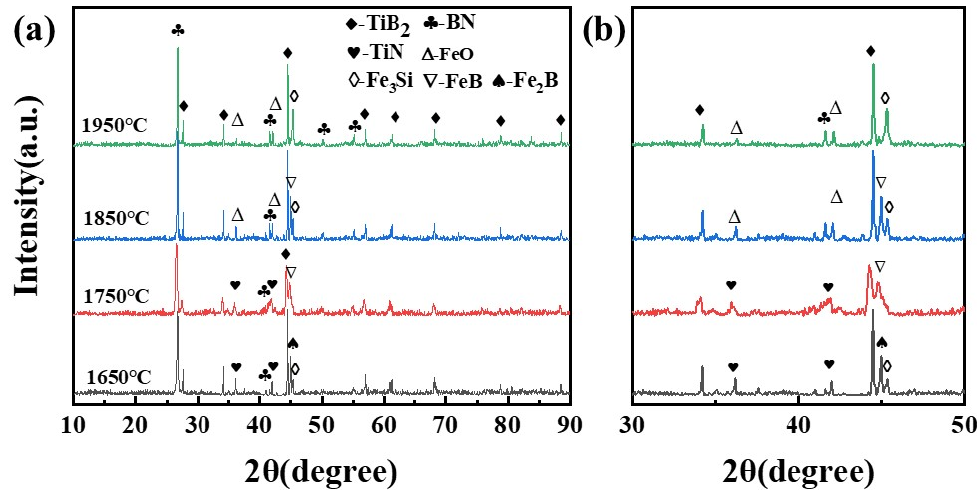
Figure 7. ( a ) XRD patterns of TiB 2 -BN-SiC composite ceramics at different sintering temperatures, ( b ) is their local feature.